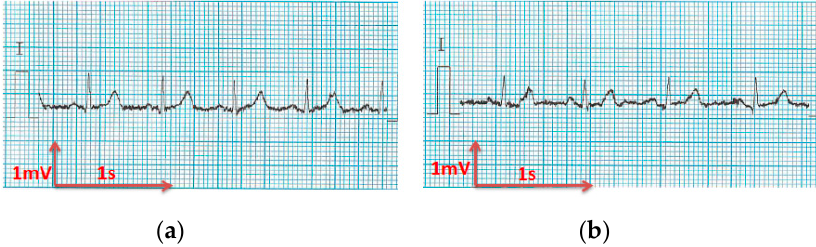
Figure 11. ECG signal obtained by 100% cotton electrodes with 12.8 wt.% PEDOT:PSS: ( a ) before washing; ( b ) after 50 washing cycles.